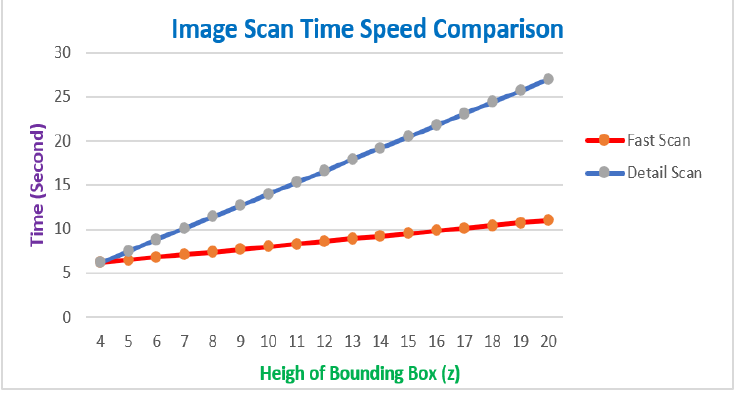
Figure 25. Result of fast scanning image and detail scanning image of the trash object.